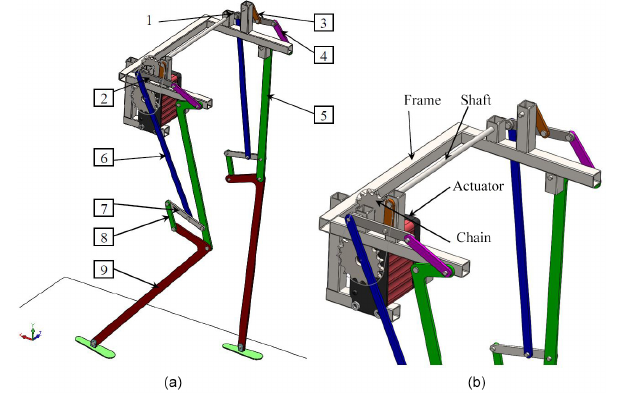
Figure 8. A virtual model of the exoskeleton in SolidWorks: (a) iso- metric view; (b) upper part detail view.